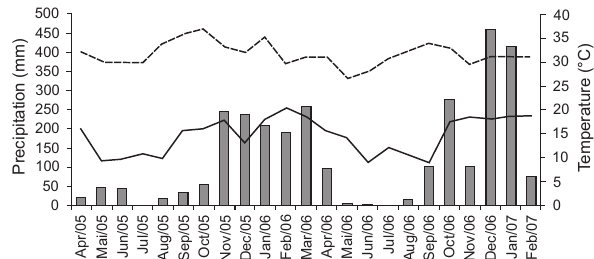
Figure 2. Climate data from the Panga Ecological Station, Minas Gerais, Brazil. ( (cid:2) ) Minimum temperature, (--) maximum tempera- ture and (bars)